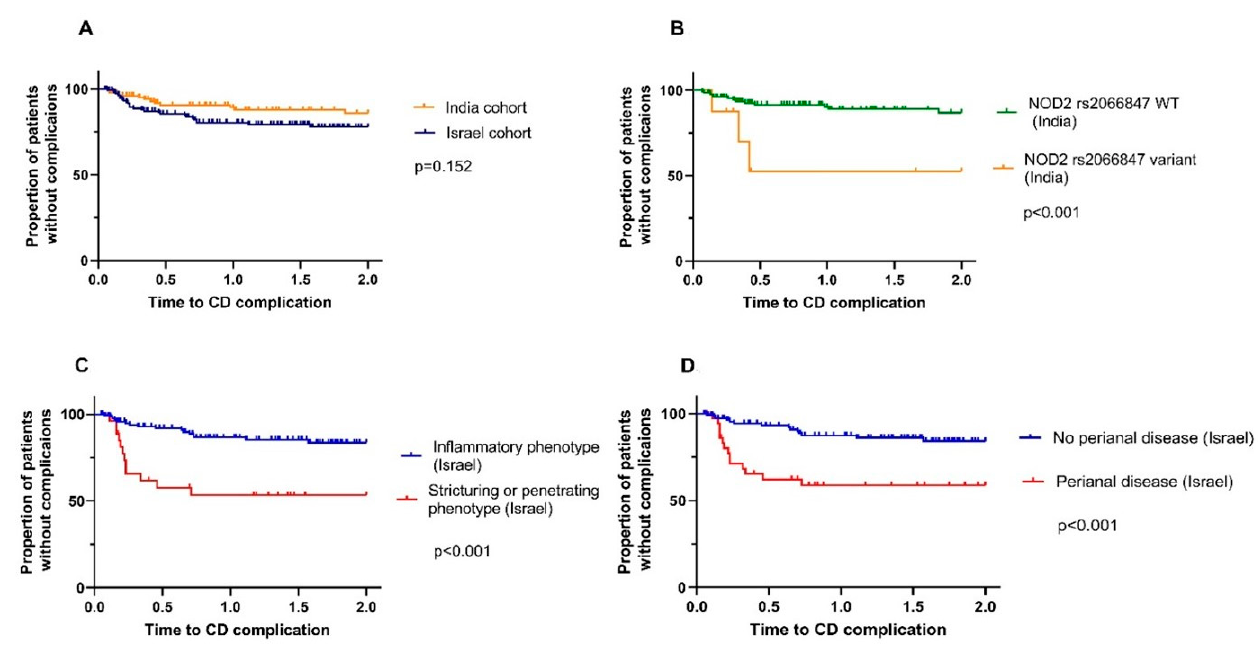
Figure 1. Kaplan–Meier plots showing the proportion of patients with newly diagnosed Crohn’s without complication, stratified by the following: ( A ) Indian and Israeli cohorts; ( B ) NOD2 rs2066847 variant in Indian cohort; ( C ) inflammatory vs stricturing and/or penetrating phenotype in Israeli cohort; ( D ) perianal disease in Israeli cohort.